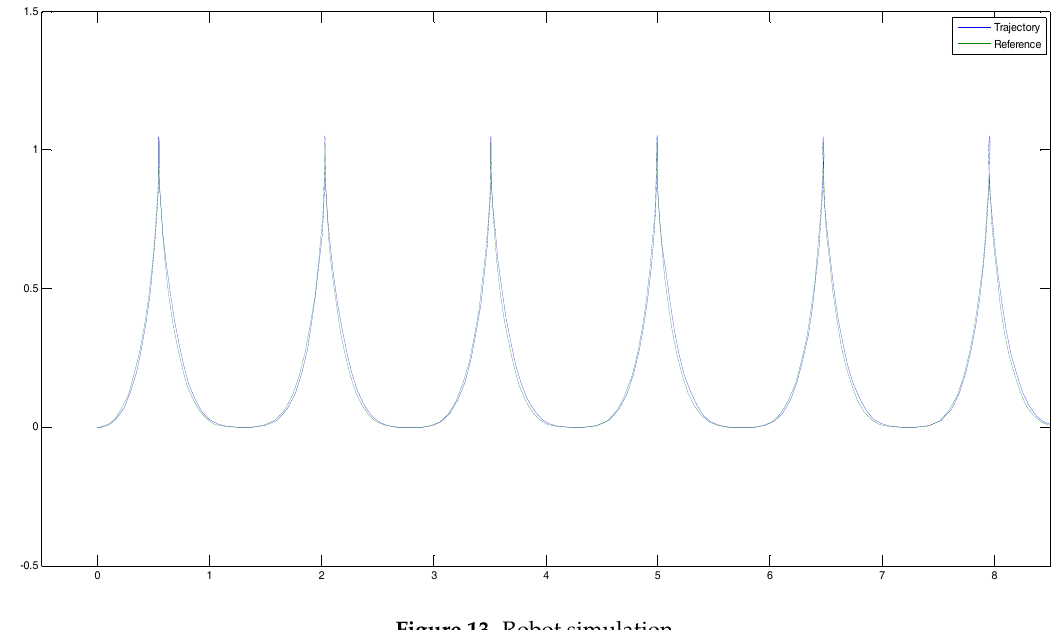
Figure 13. Robot simulation.